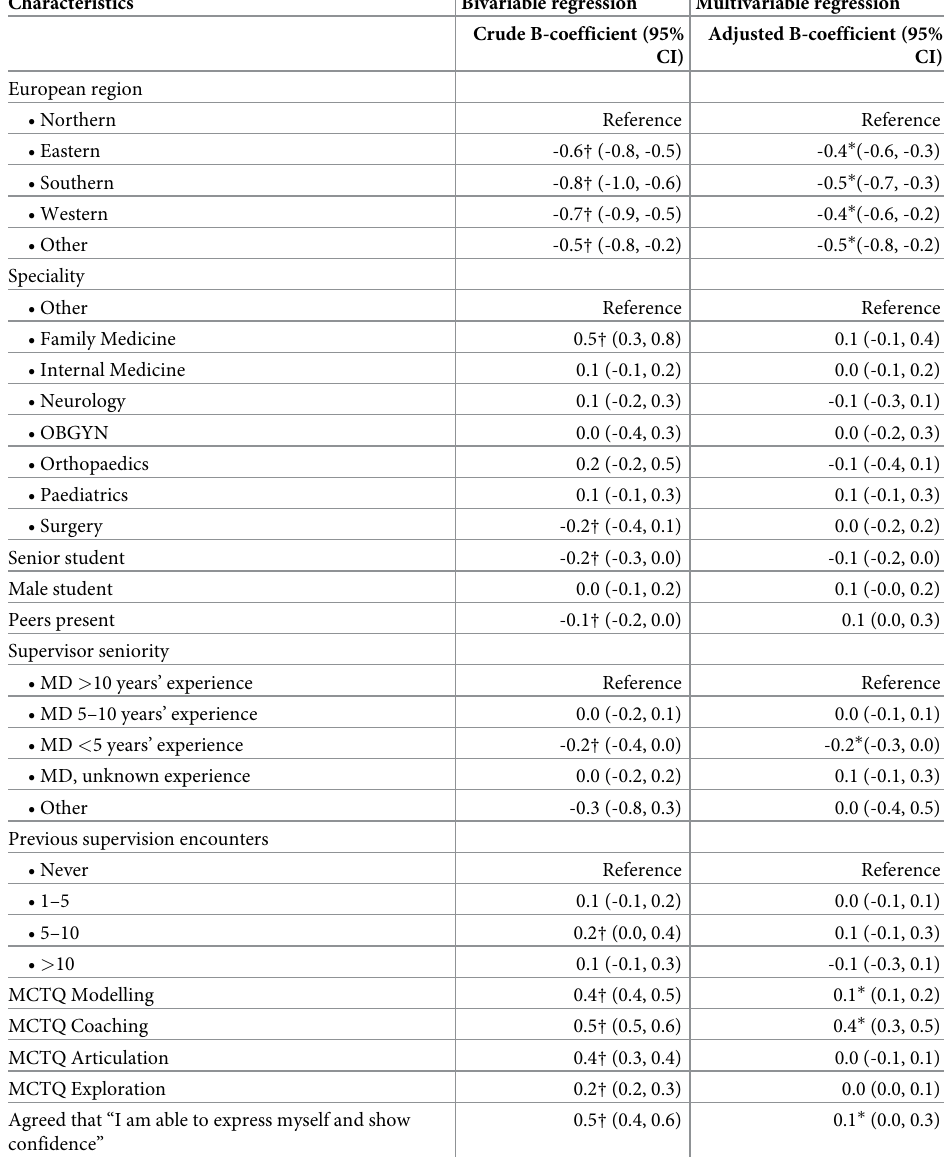
Table 2. Regression analyses of associations between psychological safety and context, student characteristics, structural aspects of clinical supervision, supervisor behaviour, and student